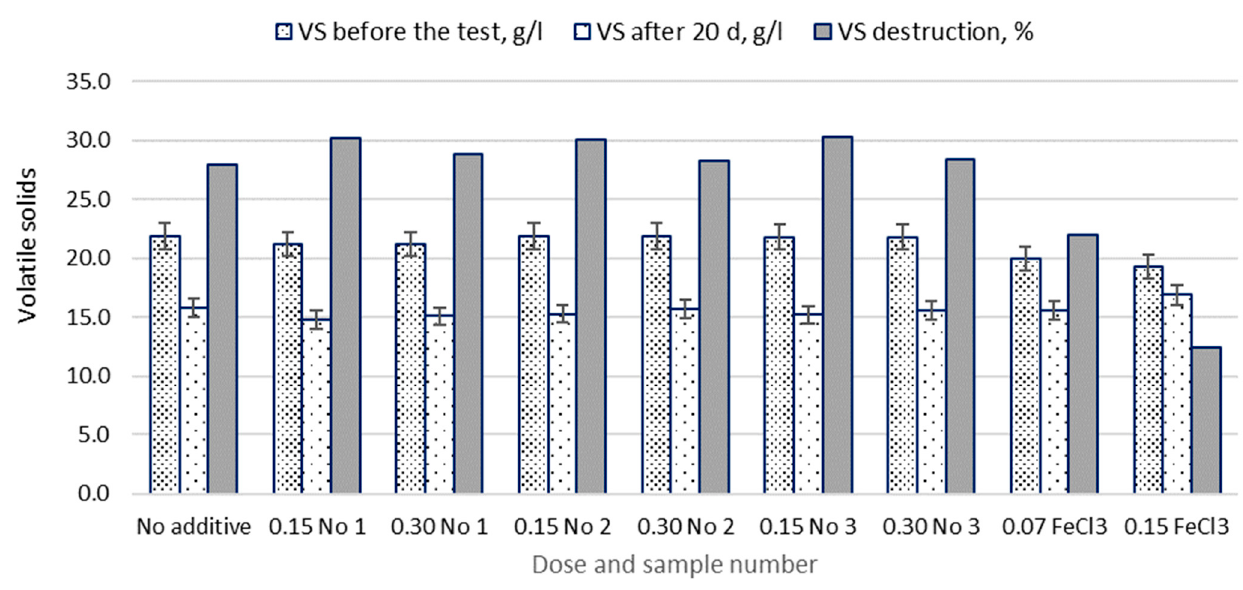
Figure 3. Average concentration of VSs and the efficiency of VSs destruction. Doses of the additives are indicated in g/g SM/20 d.